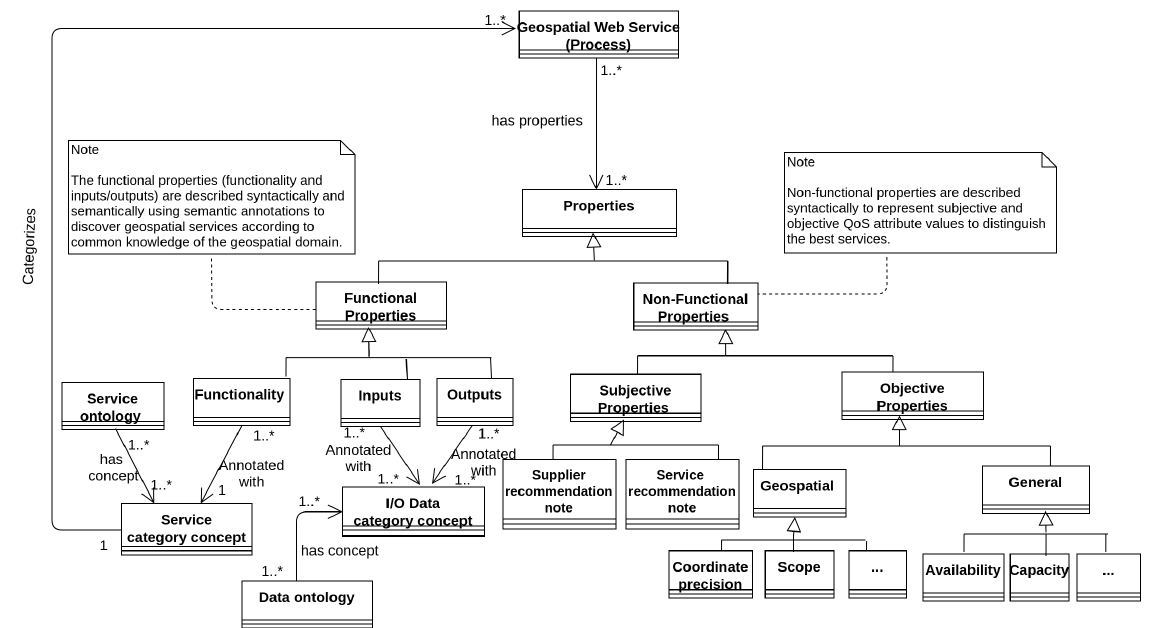
Figure 1. UML class diagram representing the meta-model of geospatial web service